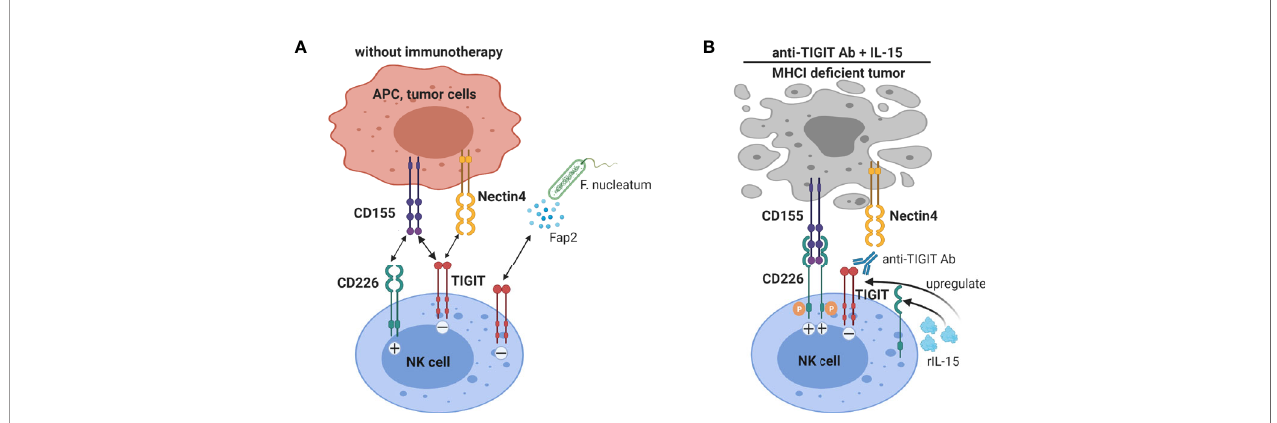
FIGURE 4 | Blockade of TIGIT on NK cells augments anti-tumor immunity. (A) NK cells expressing TIGIT are functionally impaired by binding to CD155 and nectin-4, and in colorectal cancer to Fap2 protein produced by a gut bacterium. (B) TIGIT blockade not only interrupts inhibitory signaling by TIGIT in NK cells, but also allows interaction of the co-stimulatory receptor CD226 with CD155. IL-15 treatment increases TIGIT and CD226 expression on NK cells. Thus IL-15 combined with TIGIT blockade further enhanced NK cells anti-tumor functions, especially promoting NK cell-mediated destruction of MHC class I-de fi cient